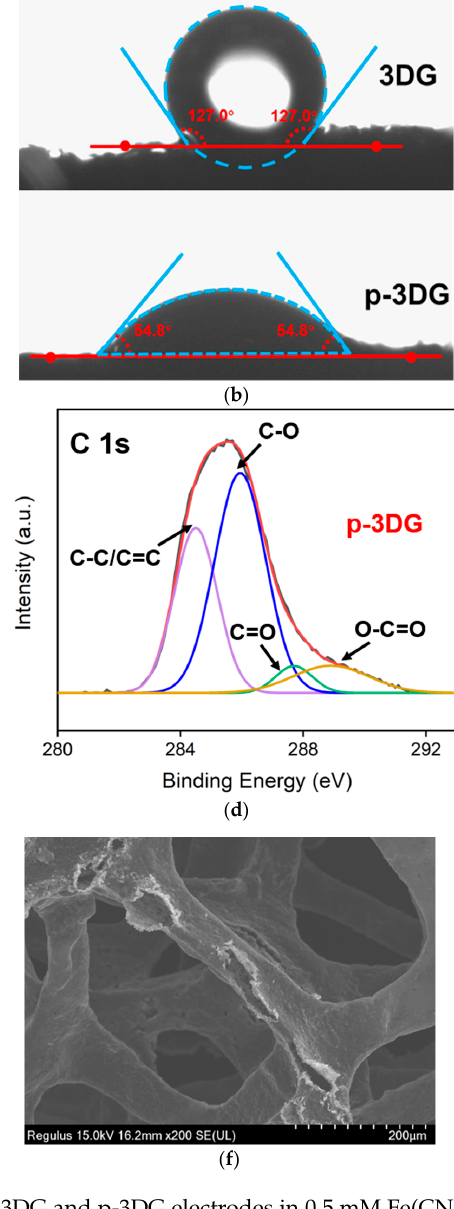
Figure 2. ( a ) CV responses obtained at 3DG and p-3DG electrodes in 0.5 mM Fe(CN) 63 − (in 0.1 M KCl medium). ( b ) Contact angle photos of 3DG and p-3DG. ( c , d ) High-resolution C 1 s XPS spectra of 3DG ( c ) and p-3DG ( d ). ( e , f ) SEM images of ( e ) 3DG and ( f ) VMSF/p-3DG.